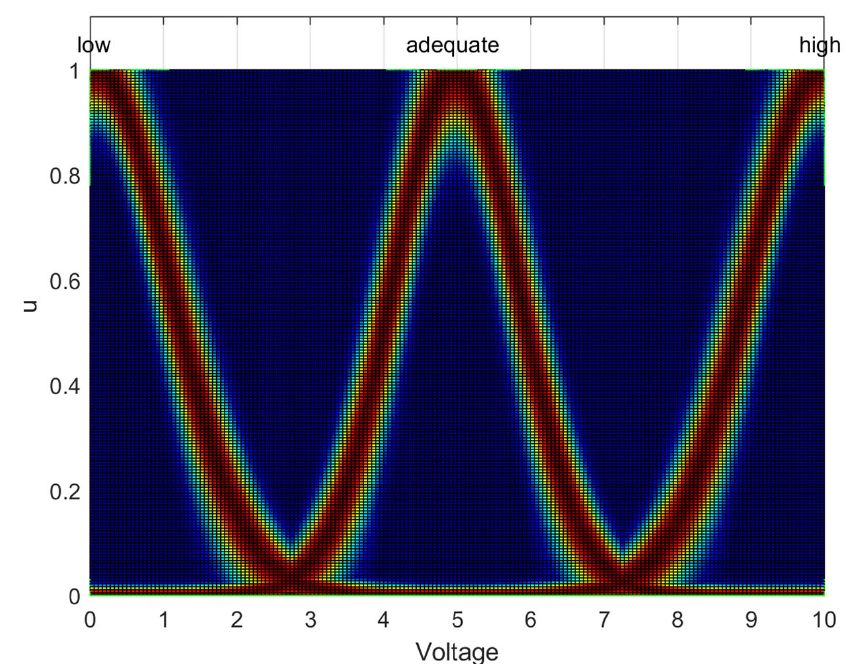
Figure 5. Nonmembership functions of the voltage input variable.